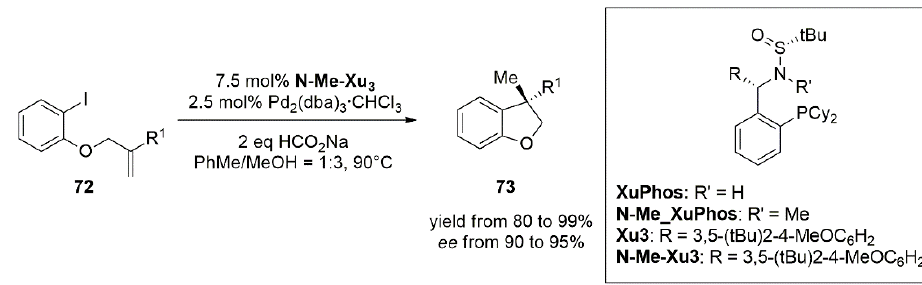
Figure 32. Asymmetric intramolecular reductive Heck reaction of allyl aryl ethers ( 72 ).